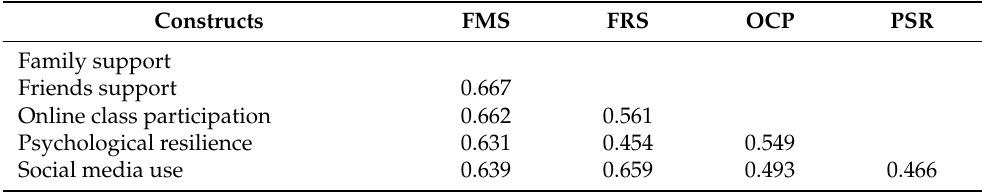
Table 3. Heterotrait–monotrait ratio of correlations (HTMT).